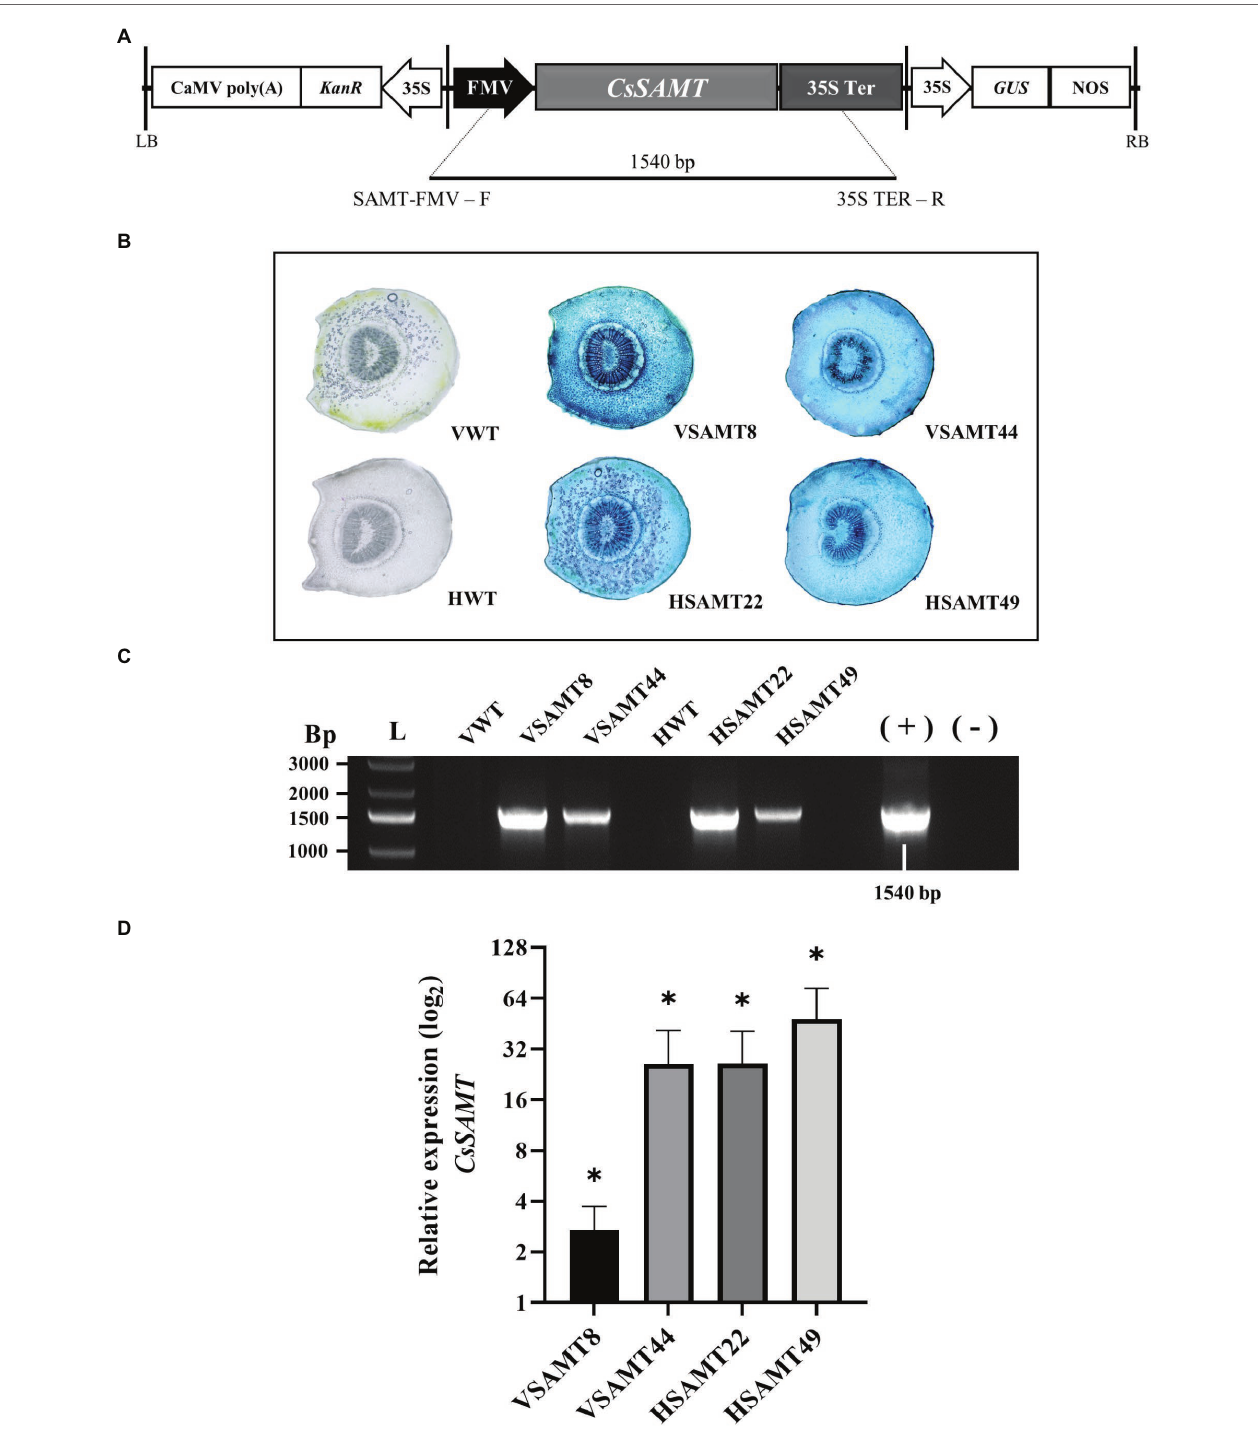
FIGURE 2 | Identification of transgenic sweet orange plants overexpressing CsSAMT . (A) T-DNA region of the binary vector used for Agrobacterium tumefaciens - mediated transformation; (B) GUS assay of transgenic CsSAMT petioles, wild-type Valencia (VWT), and Hamlin (HWT) as negative controls. (C) Amplification of a 1,540 bp fragment of the transformed lines; (L) - GeneRuler 1 kb Plus DNA Ladder (Sigma–Aldrich); Valencia (VWT) and Hamlin (HWT) nontransformed controls, respectively; transformants from Valencia (VSAMT8 and VSAMT44); − transformants from Hamlin (HSAMT22 and HSAMT49); (+) – positive control; ( − ) – negative control; and (D) Relative expression of CsSAMT in transgenic sweet orange with nontransformed plants used as control. Three biological independent experiments were performed. Asterisks ( * ) indicate statistically significant differences based on Student’s t -test ( p <